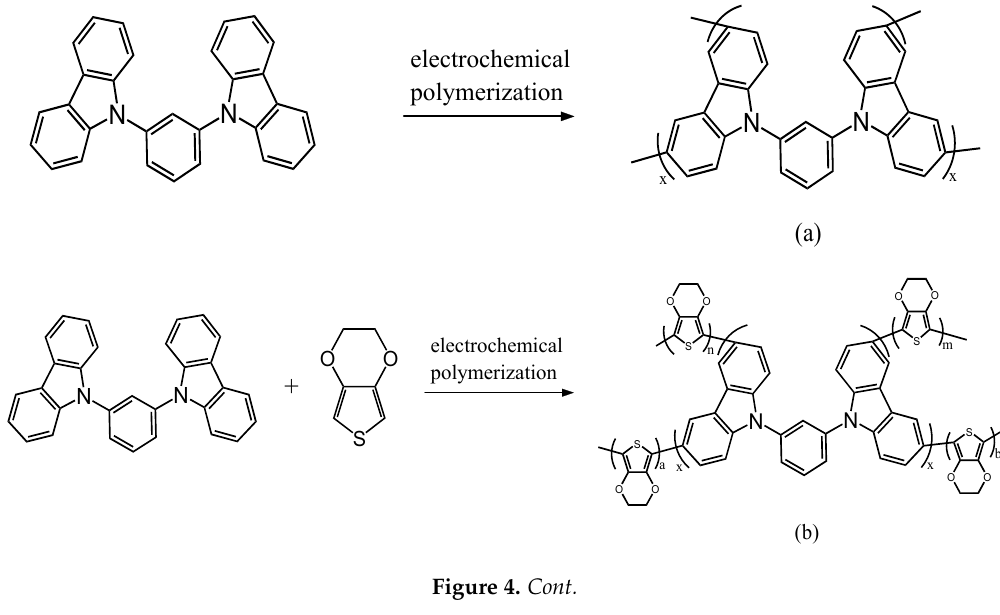
Figure 4. Cont. Figure 4.